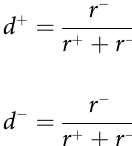
Algorithm 1: The hybrid two-level heuristic